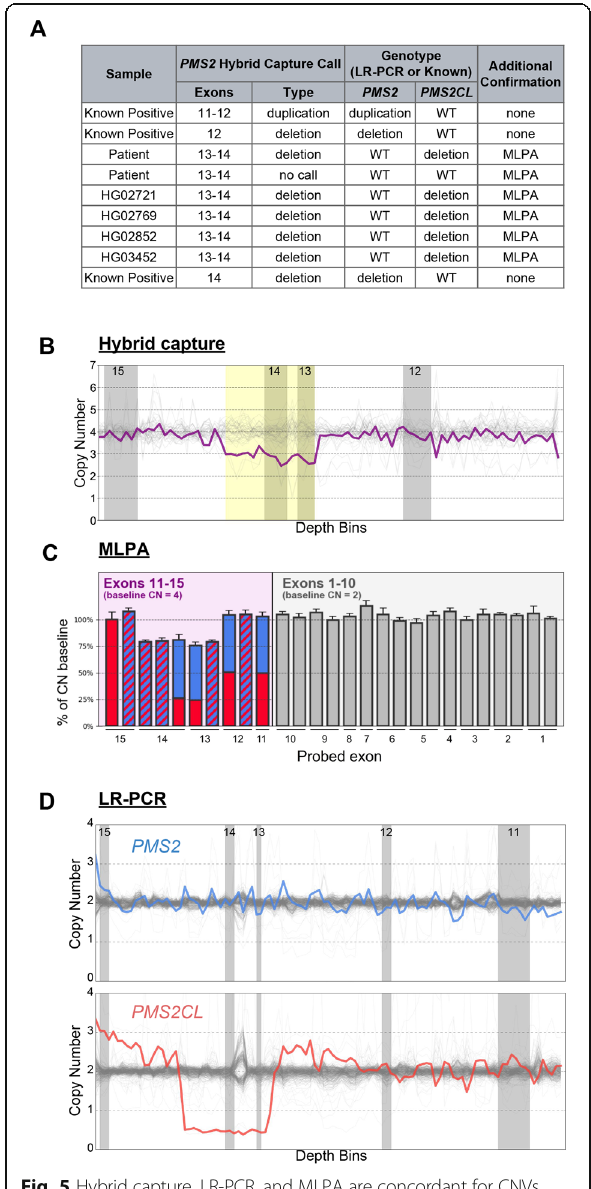
Fig. 5 Hybrid capture, LR-PCR, and MLPA are concordant for CNVs. a All CNVs called in the hybrid capture data and corresponding orthogonal confirmation data. b Hybrid capture data for the patient sample with an exon 13 – 14 deletion depicts copy-number estimates across the locus (bins). Gray regions denote the last four exons of PMS2 . White regions denote introns. Yellow box indicates region of the CNV call. c MLPA data for the exon 13 – 14 deletion patient sample. PMS2 -specific (solid blue), PMS2CL -specific (solid red), and PMS2 / PMS2CL degenerate MLPA probes (blue and red stripes) show the deletion in exons 13 – 14 of PMS2CL . d LR-PCR data for the exon 13 – 14 deletion sample depicting copy number estimates across the locus (bins) for PMS2 (blue, top) and PMS2CL (red, bottom). Gray regions depict exons 11 – 15 of PMS2 and white regions depict introns as in ( b